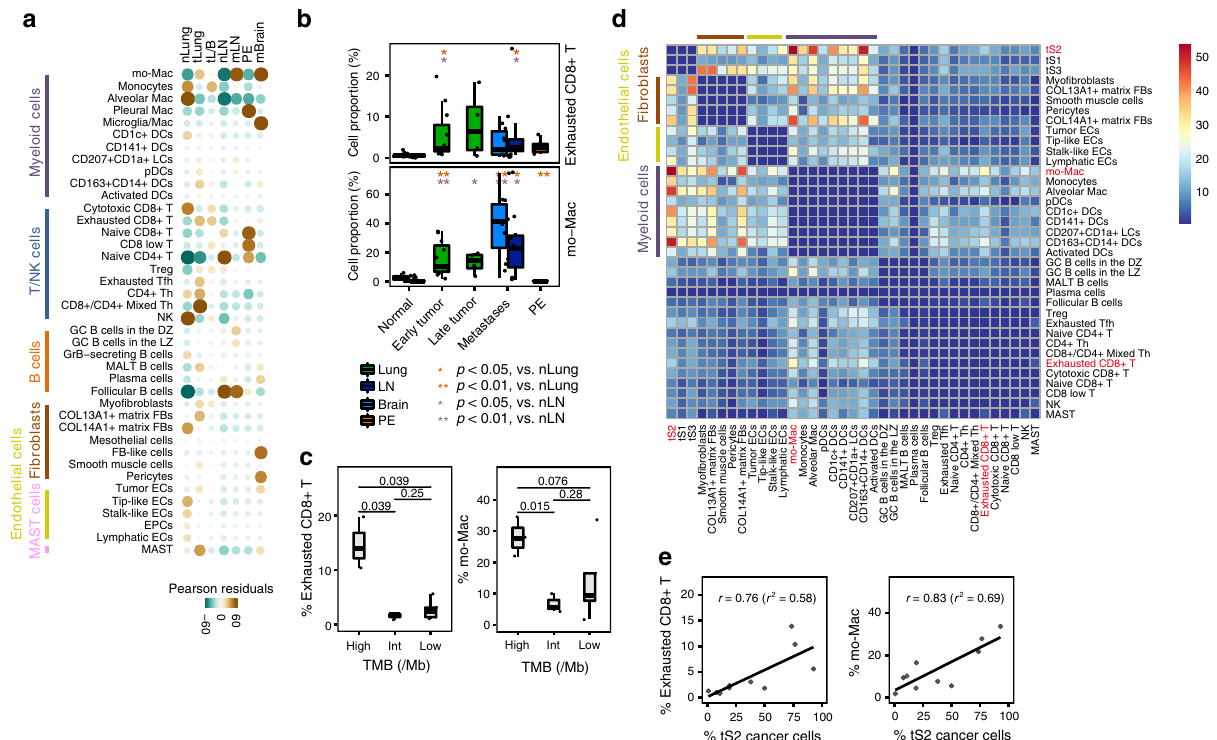
Fig. 6 Phenotypic changes during LUAD progression and metastases. a Tissue distribution map for each of the 40 immune and stromal cell subsets. Pearson residual calculated using the chi-square test was used to adjust cell-sampling biases between tissue origins. Brown and green colors indicate enrichment and depletion, respectively. Circle size is proportional to the contribution of a given cell. b Increased proportion of exhausted CD8 + T cells/ mo-Macs during LUAD progression and metastases. Immune cell proportion was estimated within a non-epithelial compartment. * p < 0.05; ** p < 0.01, two-sided Student ’ s t test. nLung, n = 11 samples; tLung, n = 11 samples; tL/B, n = 4 samples; nLN, 10 samples; mLN, n = 7 samples; PE, n = 5 samples, mBrain, n = 10 samples. c Enrichment of exhausted CD8 + T cells/mo-Macs in tLung samples with a high mutational burden (TMB). The signi fi cance was determined using two-sided Student ’ s t test. high, n = 3 samples, int, n = 3 samples, low, n = 5 samples. d Heat map depicting the number of signi fi cant interactions between tLung cell subsets. e Association between proportional changes in exhausted CD8 + T cells/mo-Macs and tS2 cancer cells in tLung. The proportion of tS2 cells was estimated with respect to all malignant cells in each sample. Top-right text ( r and r 2 ) represents Pearson ’ s correlation and its coef fi cient of determination. In the box plot in b and c, each box represents the interquartile range (IQR, the range between the 25th and 75th percentile) with the mid-point of the data, whiskers indicate the upper and lower value within 1.5 times the